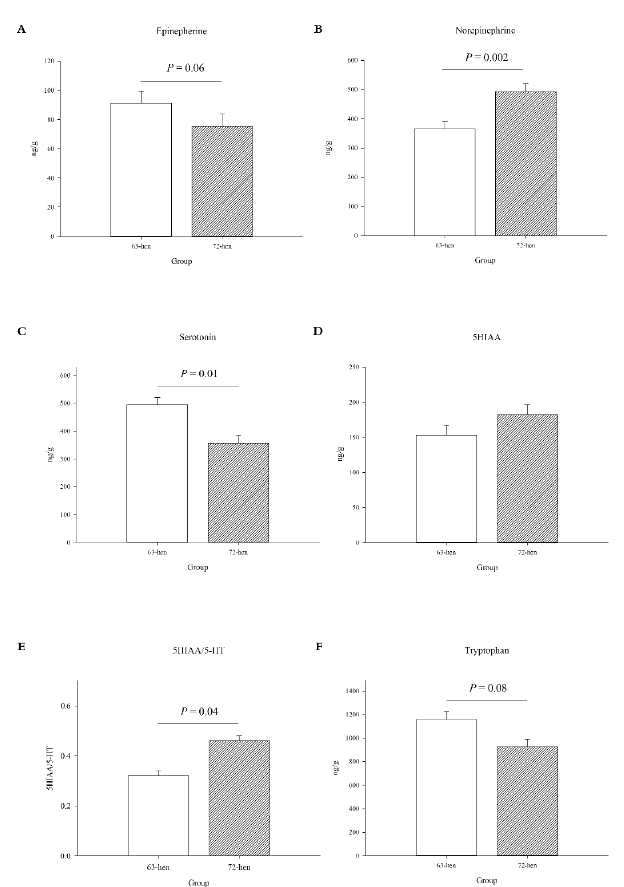
Figure 1. The measured neurotransmitters and neuropeptides in the raphe nucleus of two diversely selected chicken lines. ( A ), epinephrine (EP), ( B ), norepinephrine (NEP), ( C ), serotonin (5-HT), ( D ), 5-hydroxyindoleacetic acid (5HIAA), ( E ), 5HIAA/5-HT ratio, ( F ), tryptophan (TRP). Data are pre- sented as: LSM + SEM (n = 10). In the blood samples, TRP was higher in line 6 3 -hens than in line 7 2 -hens ( p = 0.03, Figure 2A). No difference in plasma 5-HT was found between the two lines (Table 1). The plasma CORT level was lower in line 6 3 -hens than line 7 2 -hens ( p = 0.04, Table 1). The heterophil to lymphocyte ratio was also lower in line 6 3 than line 7 2 ( p < 0.0001, Table 1). The hens from the line 6 3 tended to have higher TNF- α than those from line 7 2 ( p = 0.09). No difference was found in IL-6, IL-2, IL-10, and IgG ( p > 0.05) between the lines (Table 2).